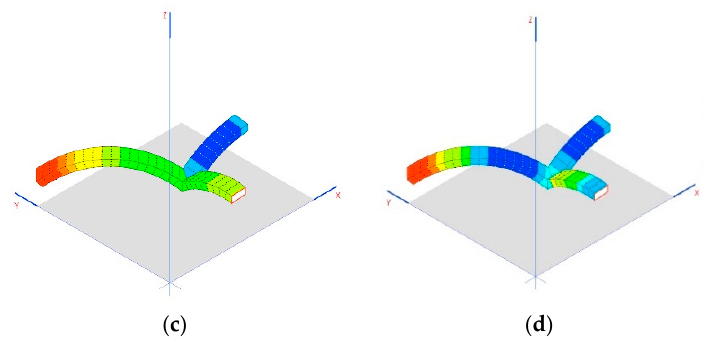
Figure 9. ( a , c ) Tractions in the dome with connecting rods at 45°; ( b , d ) traction in the dome with connecting rods at 60°.